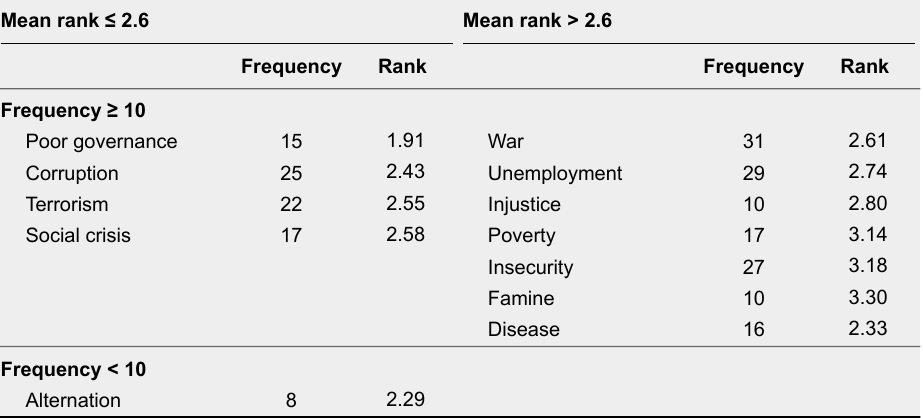
Mean rank > 2.6Mean rank ≤